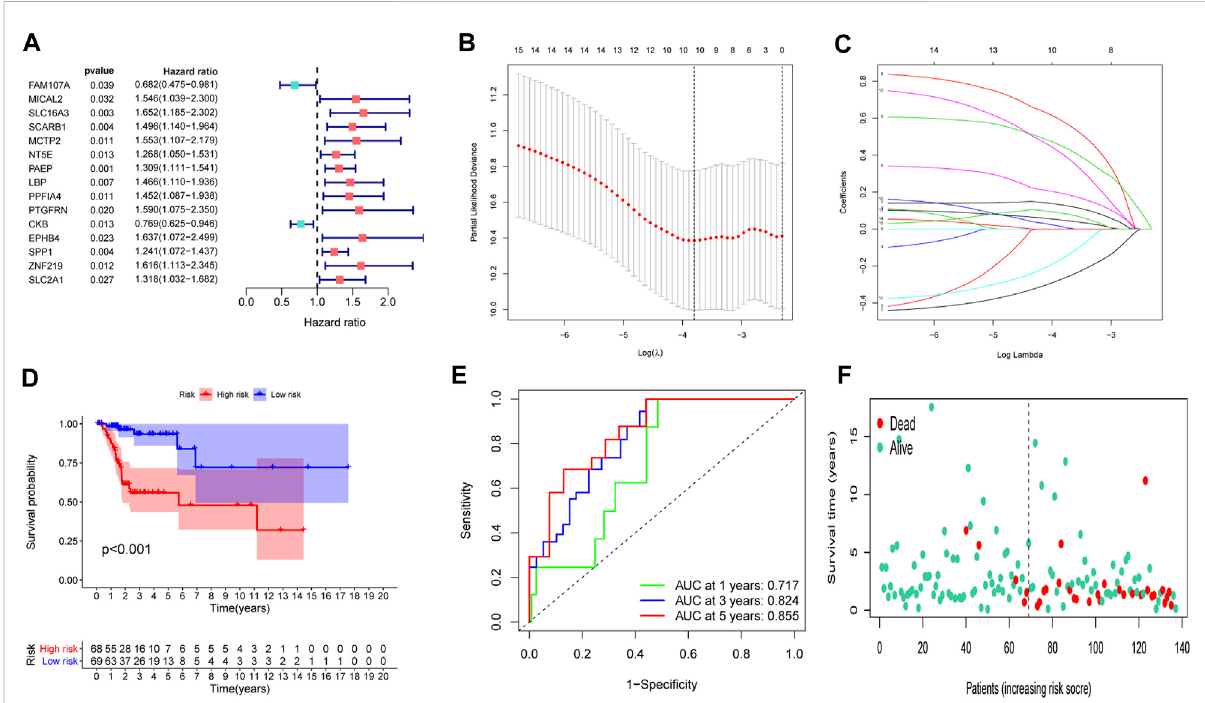
FIGURE 3 Construction of a prognostic model. (A) Univariate Cox regression analysis. (B,C) LASSO coef fi cients for model. (D) Survival analysis in the training set. (E) ROC curves of the predictive performance of the model in the training set. (F) The distribution of survival status in the training